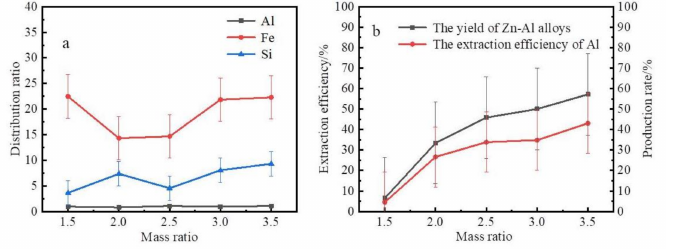
Figure 6. The influence of the mass ratio of zinc to coarse Al–Si alloy. ( a ) Effect of mass ratio on the extraction rate and yield. ( b ) The element distribution ratio of slag to alloy.